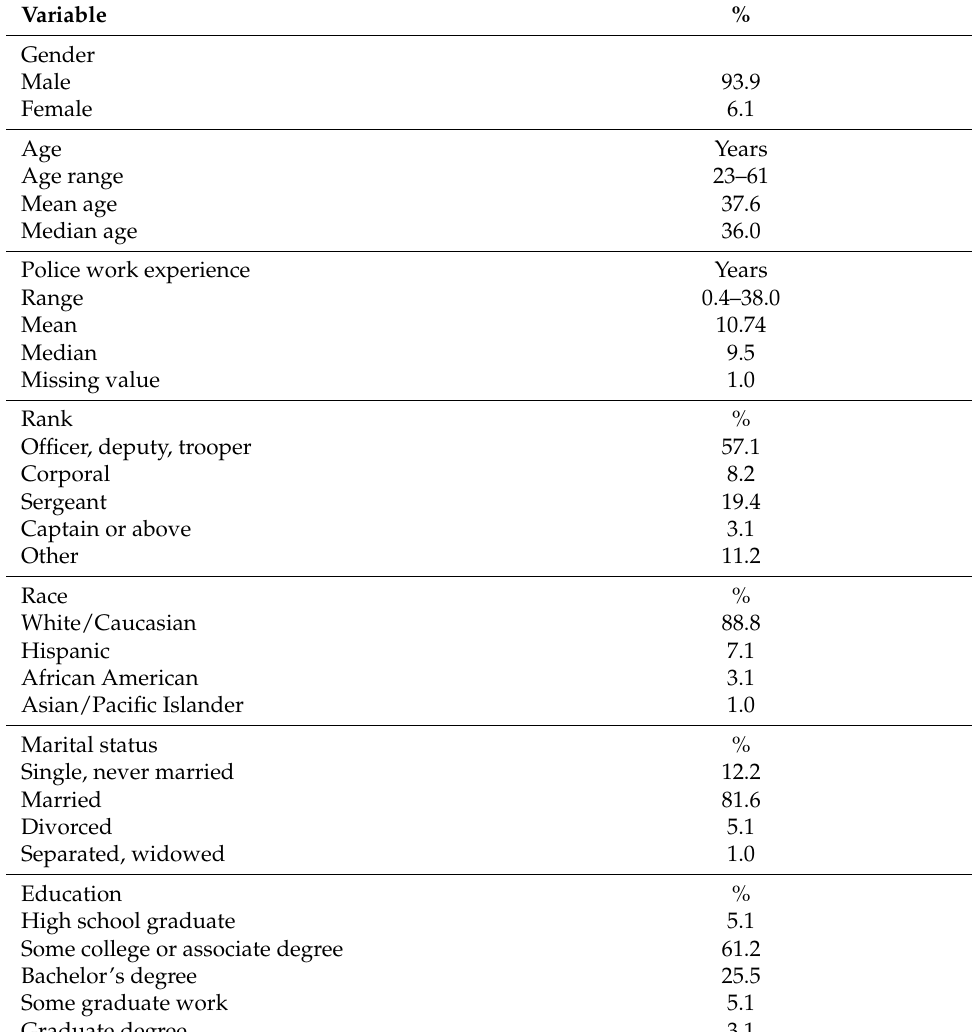
Table 1. Demographic Profile of Respondents ( n =